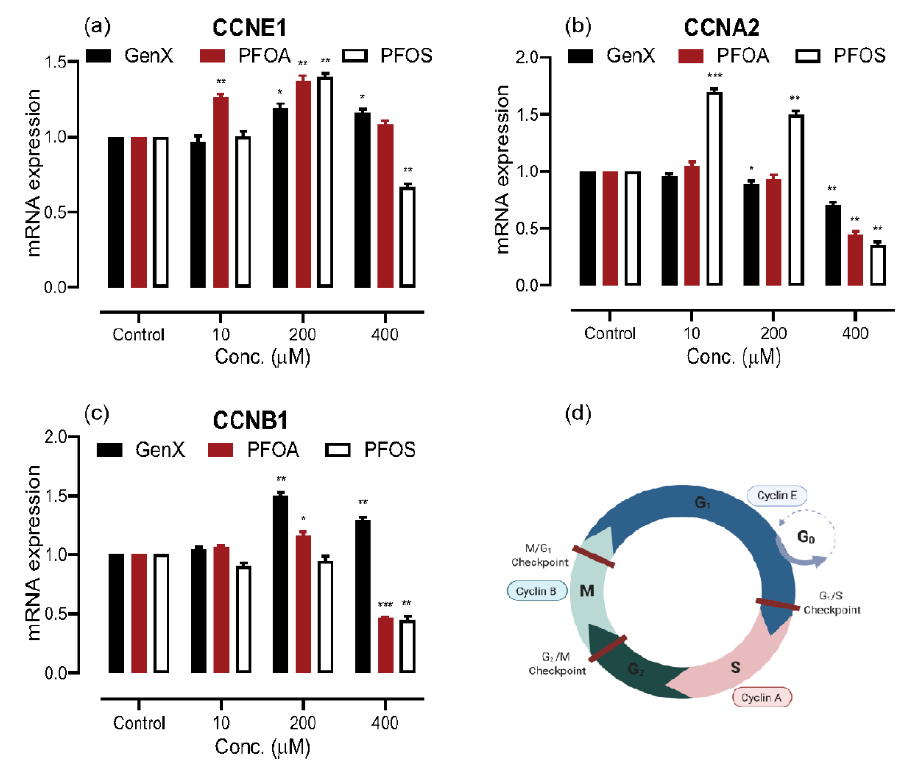
Figure 3. Analysis of cell proliferation cycle genes in A549 cells upon exposure to 10-, 200- and 400 μM concentrations of GenX, PFOA and PFOS through quantitative real-time polymerase chain reaction (qRT-PCR). ( a ) mRNA expression of cyclin (CCN)E1 shows a trend of an increase at lower concentration of all the compounds, followed by a decrease in expression as the concentration of compounds increased. ( b ) CCNA2 mRNA expression is increased upon exposure to low concentrations of PFOA and PFOS, and decreased very significantly upon exposure to 400 μM. ( c ) mRNA expression of CCNB1 increased at lower doses (more with GenX), following a very significant decrease in expression at 400 μM of PFOA and PFOS. ( d ) Normal cell cycle and the respective role of cyclins. The data are presented as the mean ± S.D. for three independent experiments (n = 3) (* = p < 0.05, ** = p < 0.005, *** = p < 0.001).